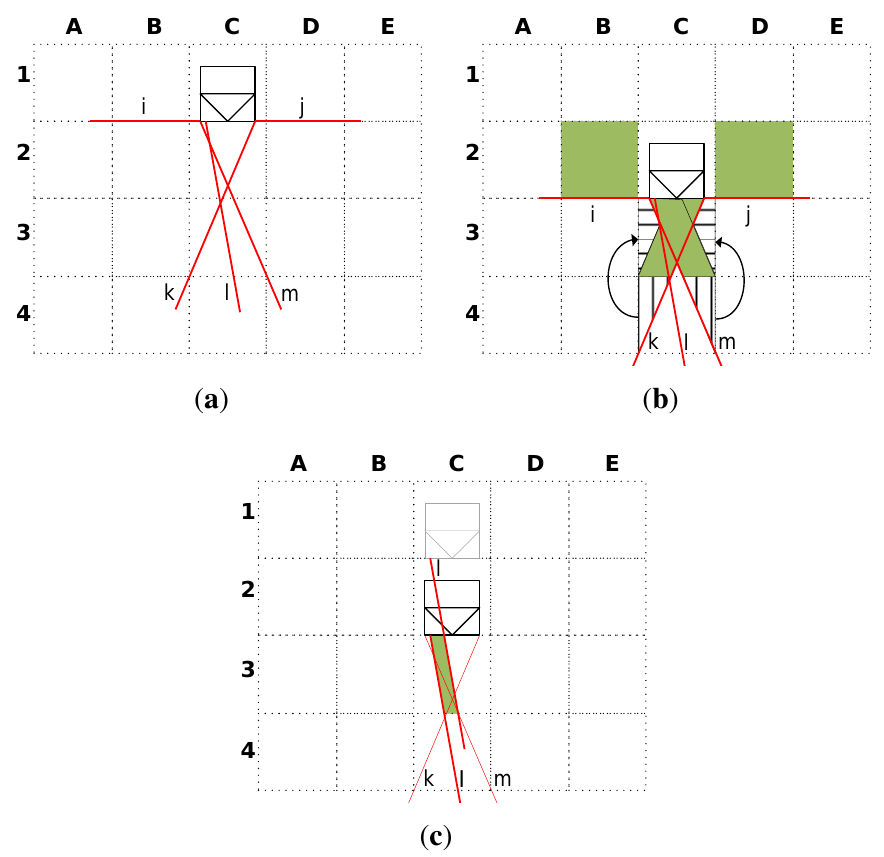
Figure 3. Cell sensing process. ( a ) Initial position at C 1 ; ( b ) sensors i , k , m and j ; ( c ) sensor l